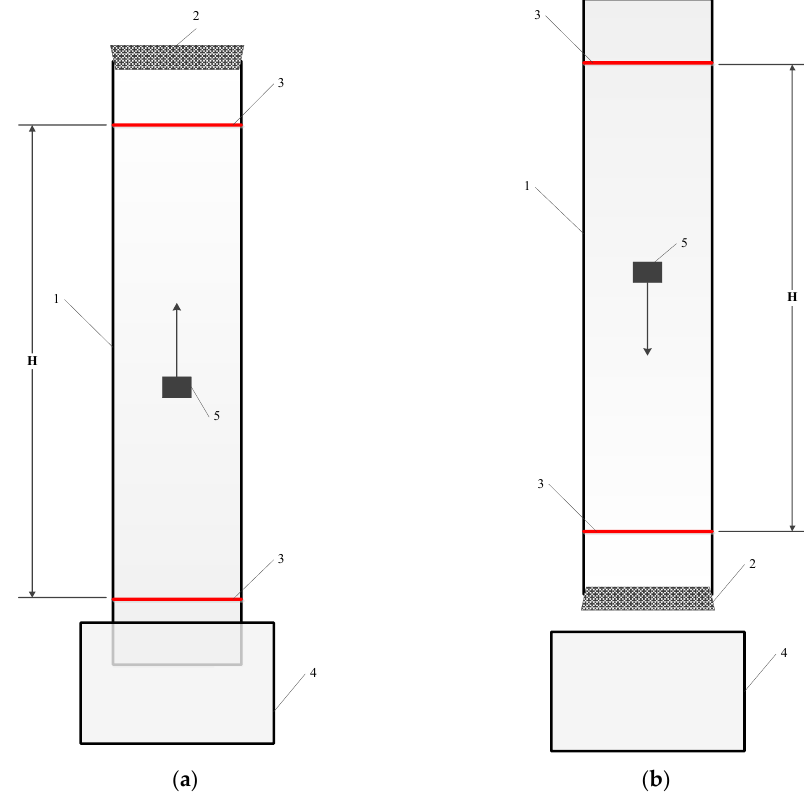
Figure 1. A sketch of apparatus used in rising ( a ) and settling ( b ) tests. 1—glass column; 2—rubber plug; 3—stripe; 4—water tank; 5—particle.